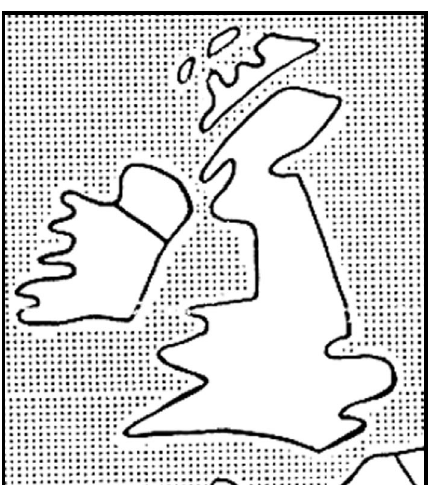
Fig 5. Contrasting colours might be hardly perceivable for a colour-blind